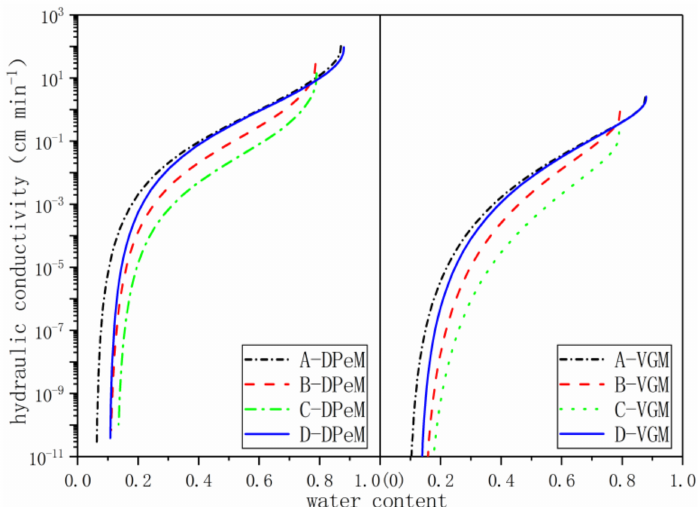
Figure 6. Waste hydraulic conductivity and moisture content curve of different